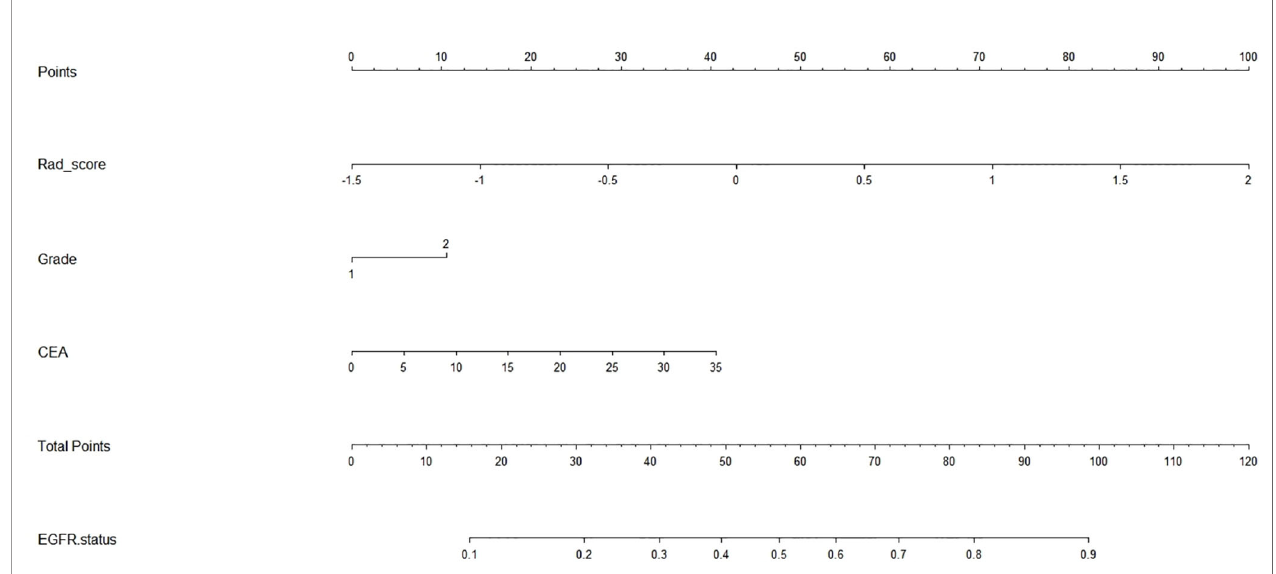
FIGURE 3 | Radiomics nomogram. The nomogram incorporated the radiomics signature with serum carcinoembryonic antigen and tumor